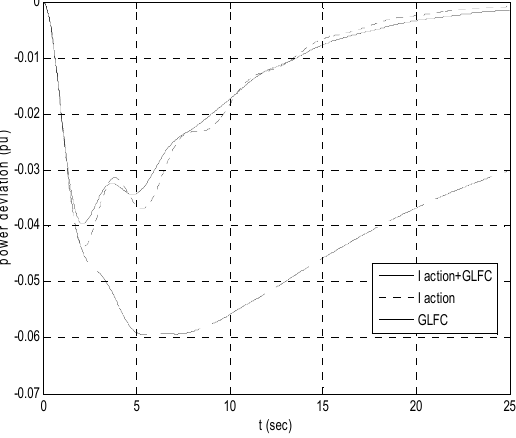
Figure 9. The frequency deviation response in area 2. (At step load change of 250 MW in area 1).